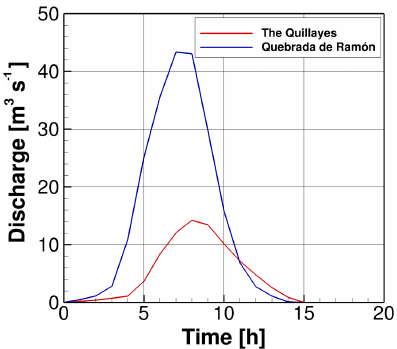
Figure 4. The 50-year return period hydrographs in both streams obtained from a hydrological model of the catchment (Ríos,